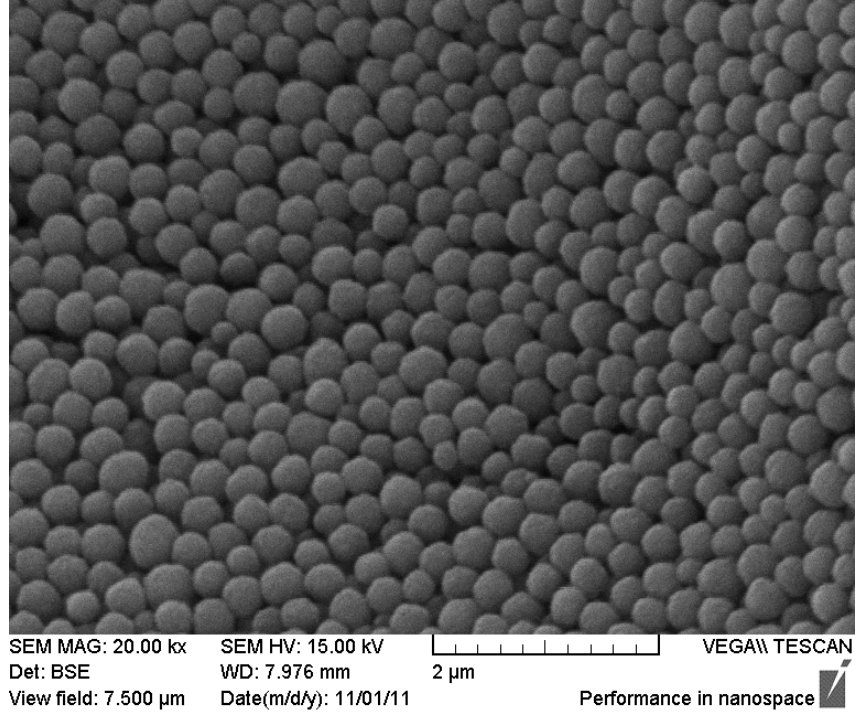
Figure 1. SEM (scanning electron microscope) image of nanoplastic particles.